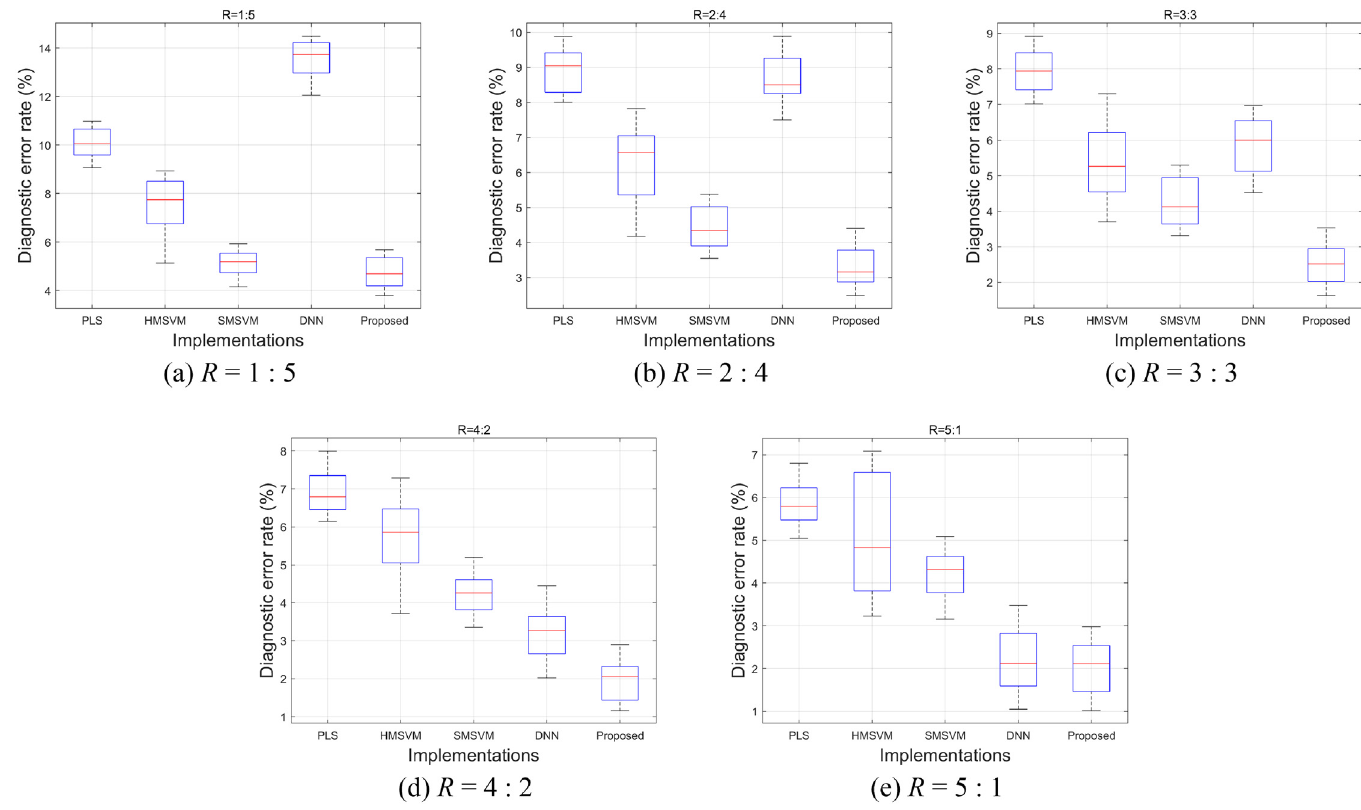
Fig 12. Diagnostic error rates of different